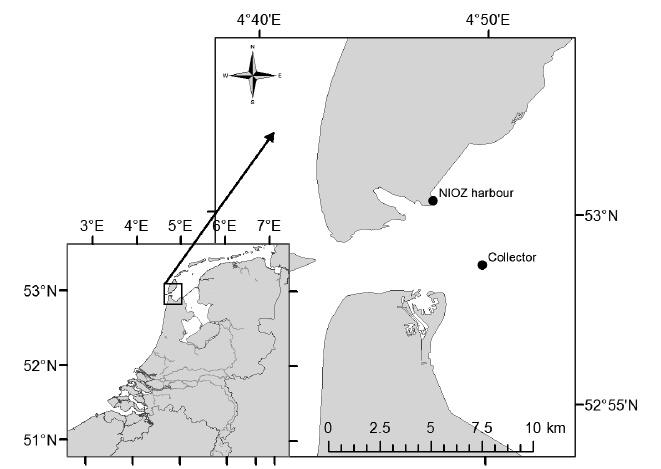
Fig. 1. Location of the pelagic mussel collector and the experimen- tal site (Royal Netherlands Institute for Sea Research [NIOZ] har- bour) in the Marsdiep (western Wadden Sea), The (Table 1) 5 mesocosms (4 for block 1) were filled with